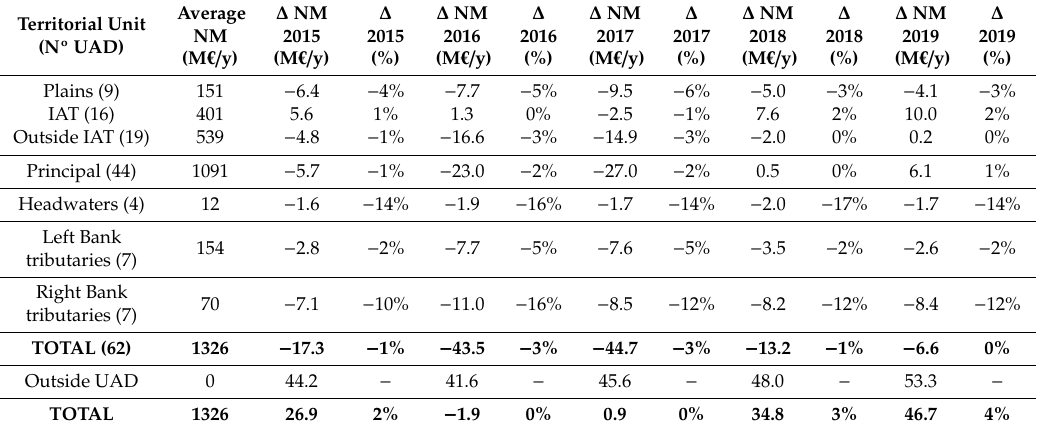
Table 12. Comparison of the net margin (NM) with respect to the average of the SBHP 2015 / 21. Source: HPO. Own